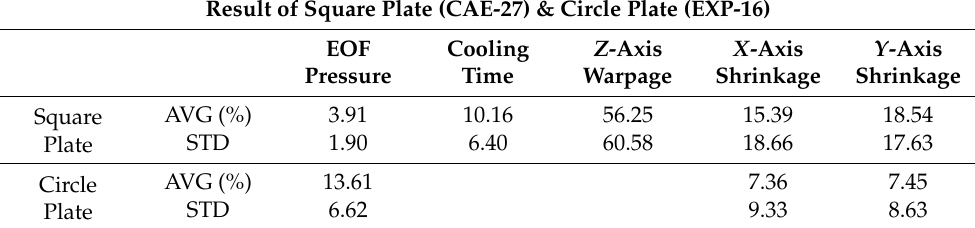
Table 24. Predicted results for square plate (CAE-27) and round plate (EXP-16).